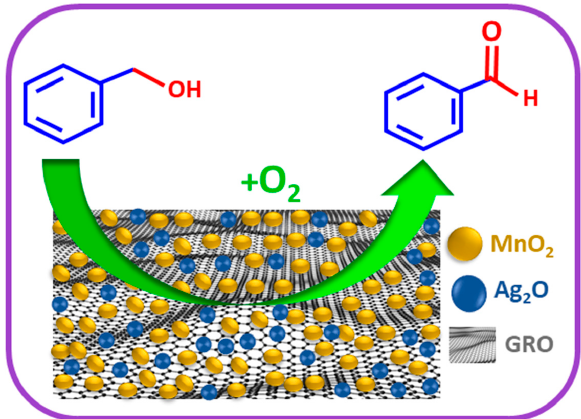
Figure 6. EDX spectrum of the (1%)Ag 2 O–MnO 2 /(5 wt.%)GRO